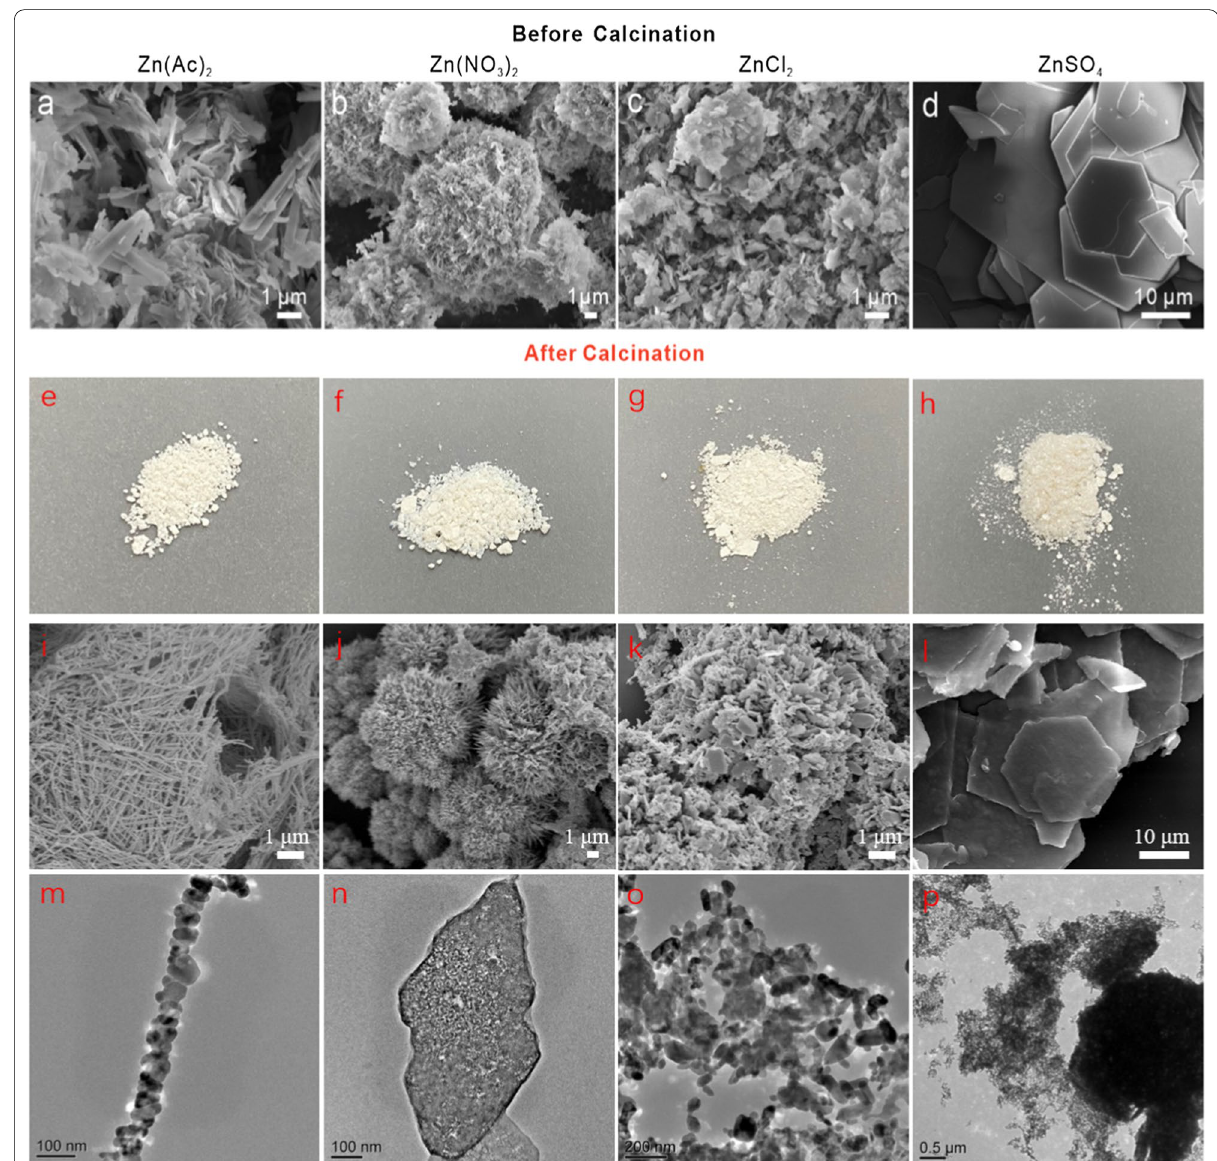
Fig. 3 SEM images, digital photographs, and TEM images of ZnO nanostructures using a , e , i , m acetate, b , f , j , n nitrate, c , g , k , o chloride, and d , h , l , p sulfate anions as zinc precursor before and after the calcination